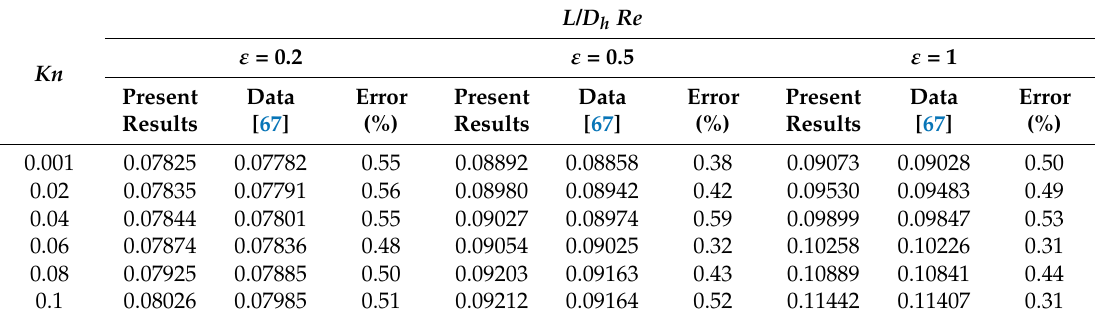
Table 1. Comparison of L / D h Re at different Knudsen numbers between the present results